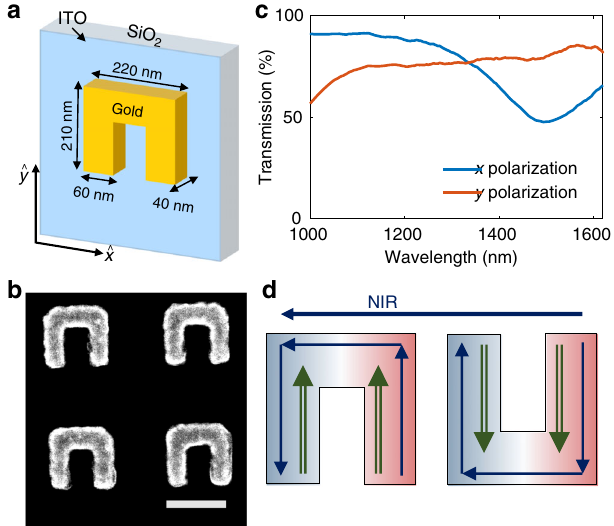
Fig. 1 Metasurface characteristics. a Structure of the split-ring resonators (SRRs) that were used as basic inclusion for the nonlinear metasurface (NLMS). b Scanning electron microscope image of the fabricated SRRs. Scale bar is 200 nm. c Transmission plot for horizontal and vertical polarizations (relative to the SRR orientation in a ), showing a dip in the transmission around 1500 nm in the horizontal polarization, associated with the magnetic resonance of the SRR. d Illustration of excited linear and nonlinear currents in SRR. Excitation with near infrared (NIR) pulse (blue) polarized along the x axis excites surface currents along the SRR. As a result, nonlinear currents (green) are generated along the arms of the SRR, in the y axis